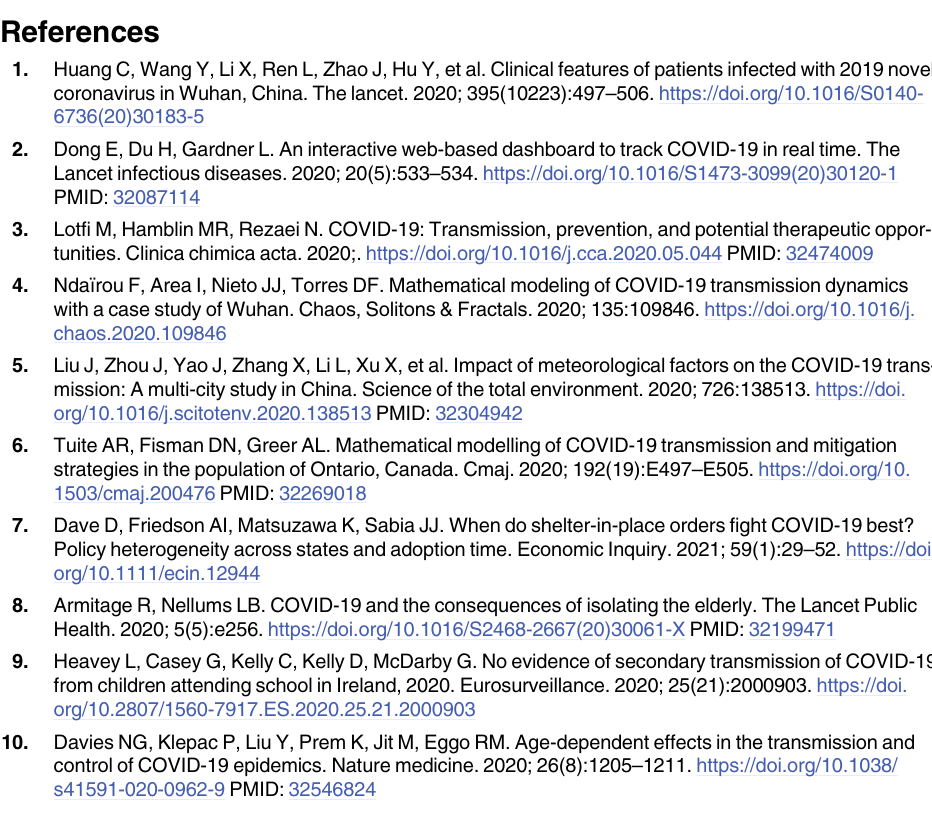
S8 Table. Step-wise regression method for relative importance of